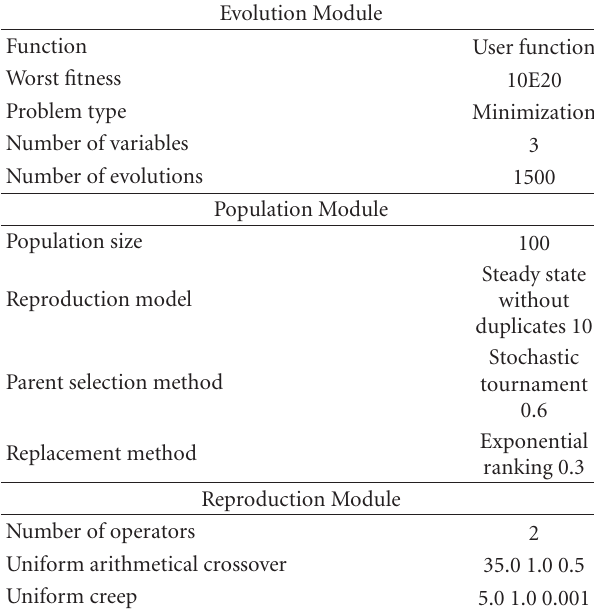
Table 2: Parameter settings used in GENIAL’s modules.